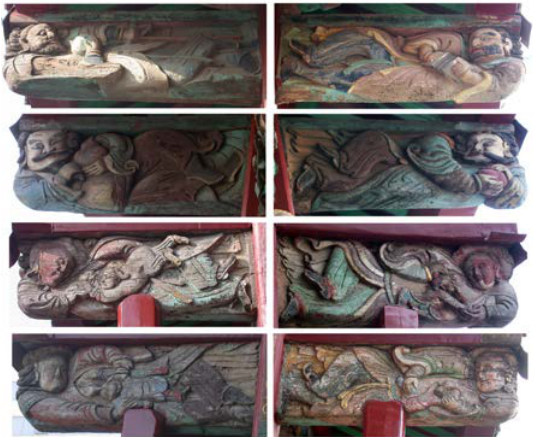
Figure 5 Sculptures on the Front Gate